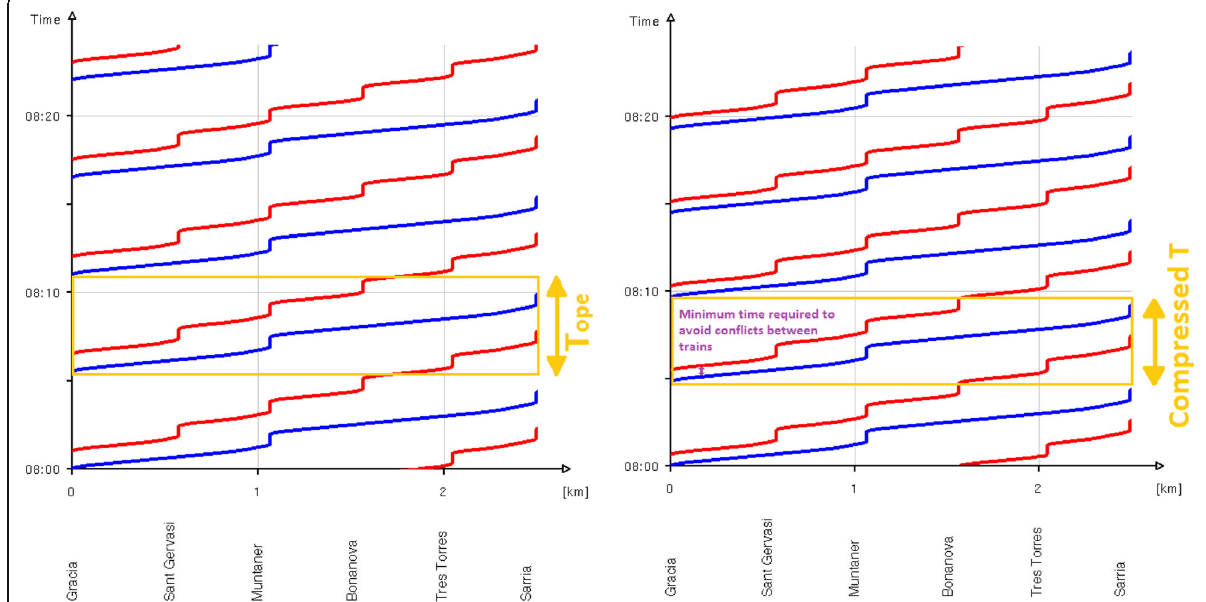
Fig. 1 Train paths diagram and the timetable compression method (Left: Uncompressed paths from the schedule. T ope reflects the periodic cycle time of 2 trains, Right: Compressed